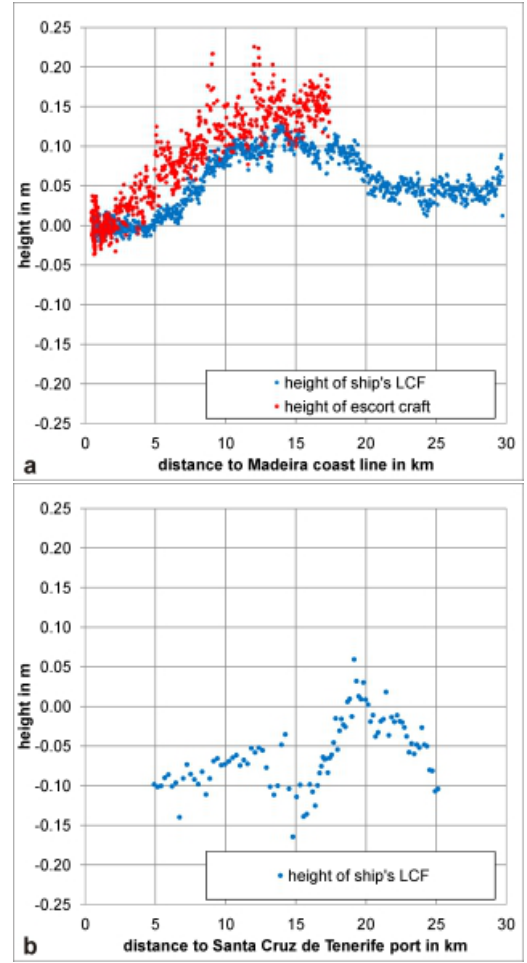
Figure 16. Heights of LCF and escort craft’s ARP at Madeira (a) and LCF height at Tenerife (b) with respect to static heights.